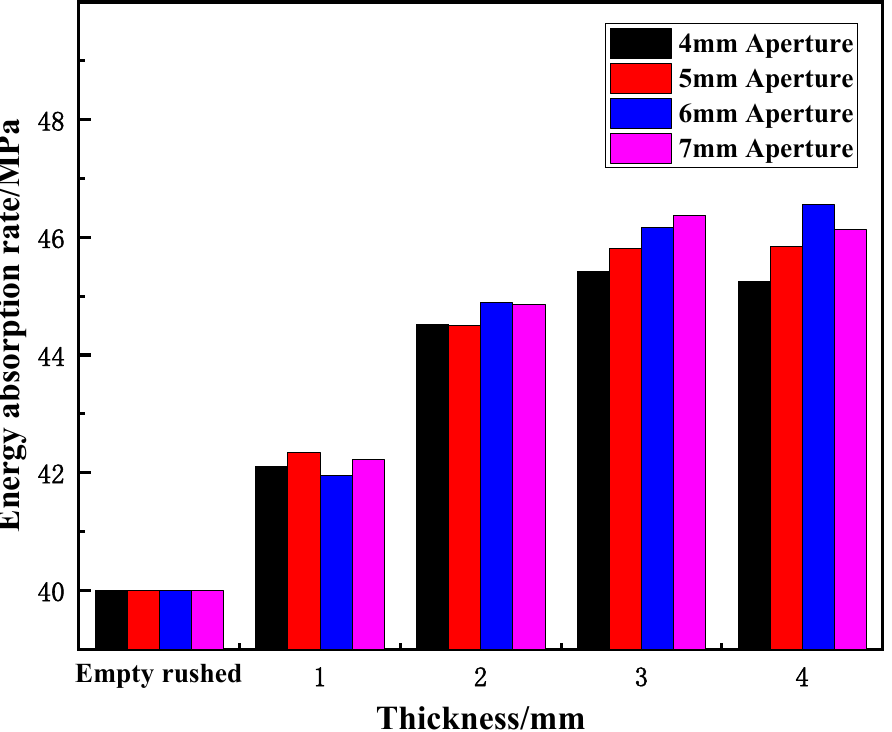
Figure 13. Variation trend of energy-absorption rate of wave-absorbing metal plate sample with thickness.